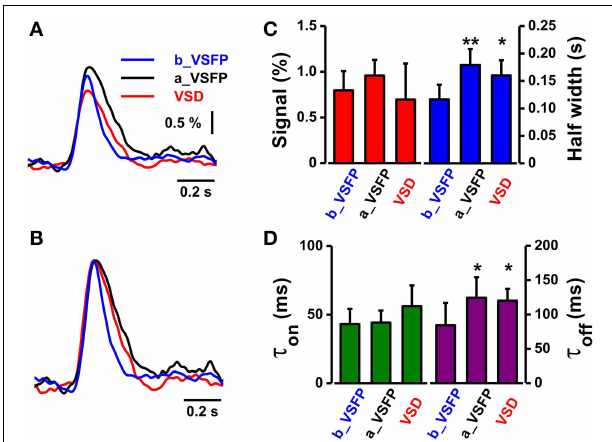
FIGURE 6 | Comparison of the kinetics of VSFP2.3 and RH1691 signals induced by C1 whisker deflection. (A) Average VSFP2.3 and RH1691 signals from five mice: VSFP2.3 signals before RH1691 staining (blue, b_VSFP), VSFP2.3 signals after RH1691 staining (black, a_VSFP), and RH1691 signals (red, VSD). (B) Data from (A) normalized to peak amplitude. (C) Comparison of the mean signal amplitudes and widths (at half-maximum) taken from the voltage signals in (A) (mean ± sem). T -tests were performed for a_VSFP and VSD, both against b_VSFP; * P < 0 . 05 , ** P < 0 . 005 . (D) Comparison of the mean on-time constant ( τ on ) and decay-time constant ( τ off ) taken from the normalized voltage signals in (B) . T -tests were performed for a_VSFP and VSD, both against b_VSFP; * P < 0 . 05 , ** P < 0 . 005 .